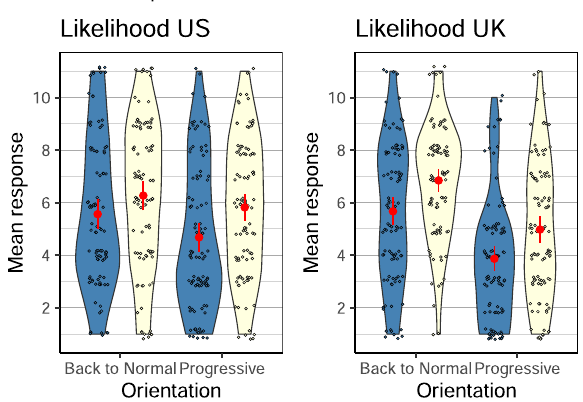
Fig. 8 Experiment 2: People ’ s judged likelihood of the scenarios as a function of the experimental variables. Left panel shows data for the US sample and the right panel shows data for the U.K. sample. The red plotting symbols and error bars represent means and 95% con fi dence intervals. Data are jittered to avoid